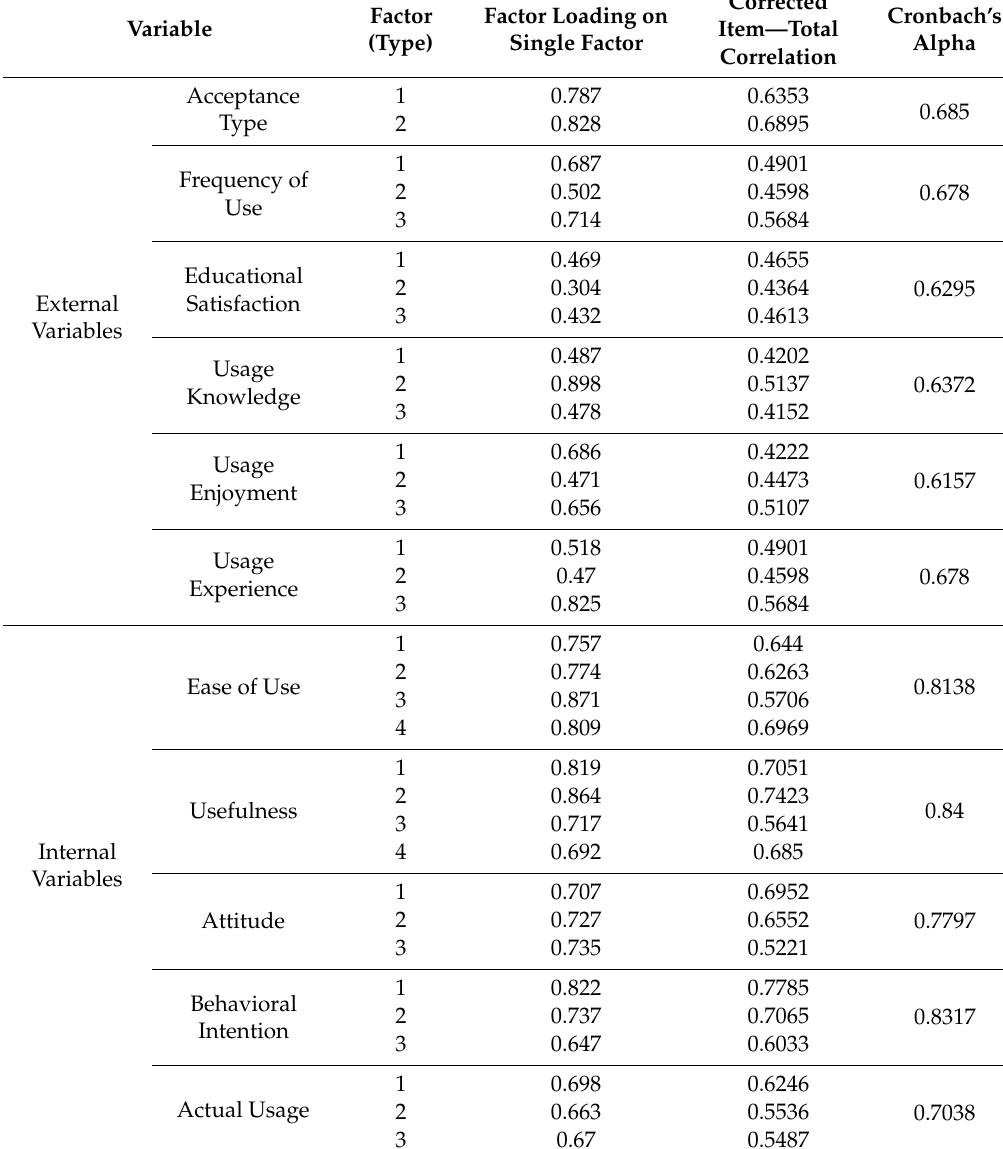
Table 2. Reliability and validity of internal and external variables in the